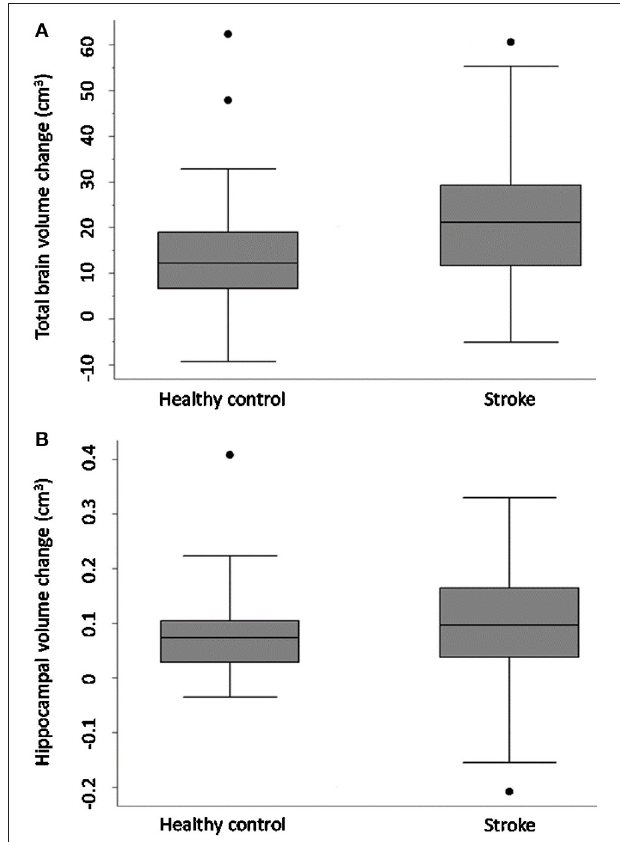
FIGURE 1 | Total brain and hippocampal volume change stroke vs. controls. Total brain volume (A) and hippocampal volume (B) change between 3-months and 3-years in stroke patients and healthy controls. Y-axis = change in brain volume (cm 3 ). Positive values represent decline in brain volumes: i.e., greater brain volume loss. Midline = median brain volume change. X-axis: n = 93 stroke, n = 39 healthy